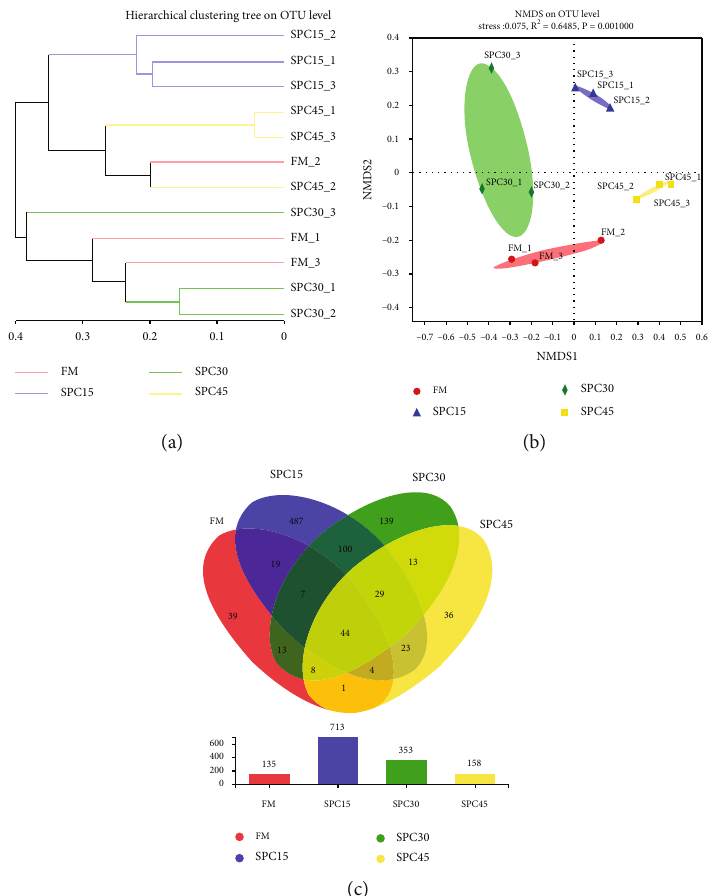
Figure 4: The intestinal microbial structure of large yellow croakers fed the experimental diets. (a) Multiple samples similarity tree; (b) nonmetric multidimensional scaling (NMDS); (c) Venn